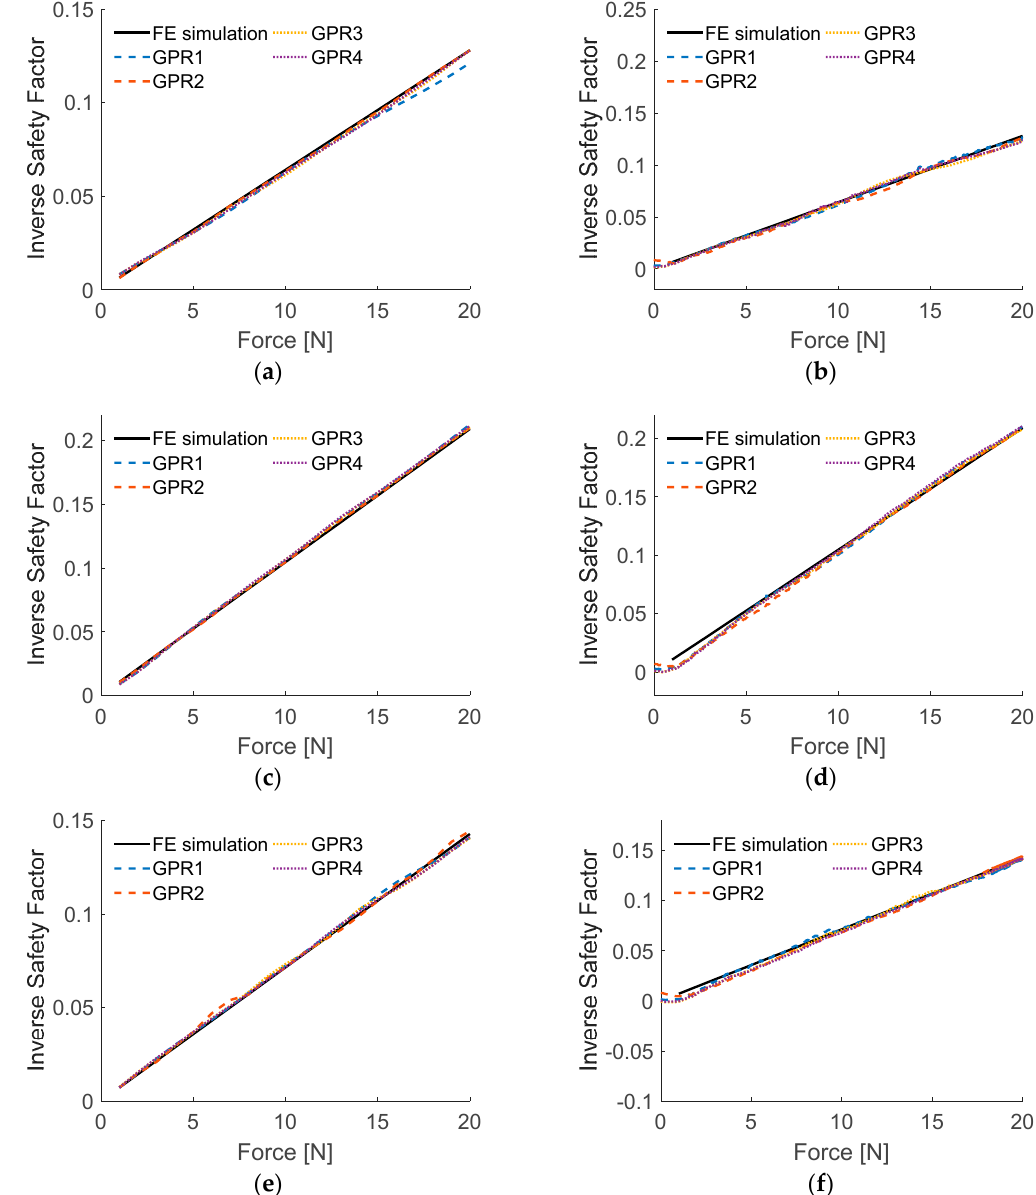
Figure 11. Results of testing GPR models: ( a ) load case LC1, numerical input data; ( b ) load case LC1, experimental input data; ( c ) load case LC2, numerical input data; ( d ) load case LC2, experimental input data; ( e ) load case LC3, numerical input data; ( f ) load case LC3, experimental input data.